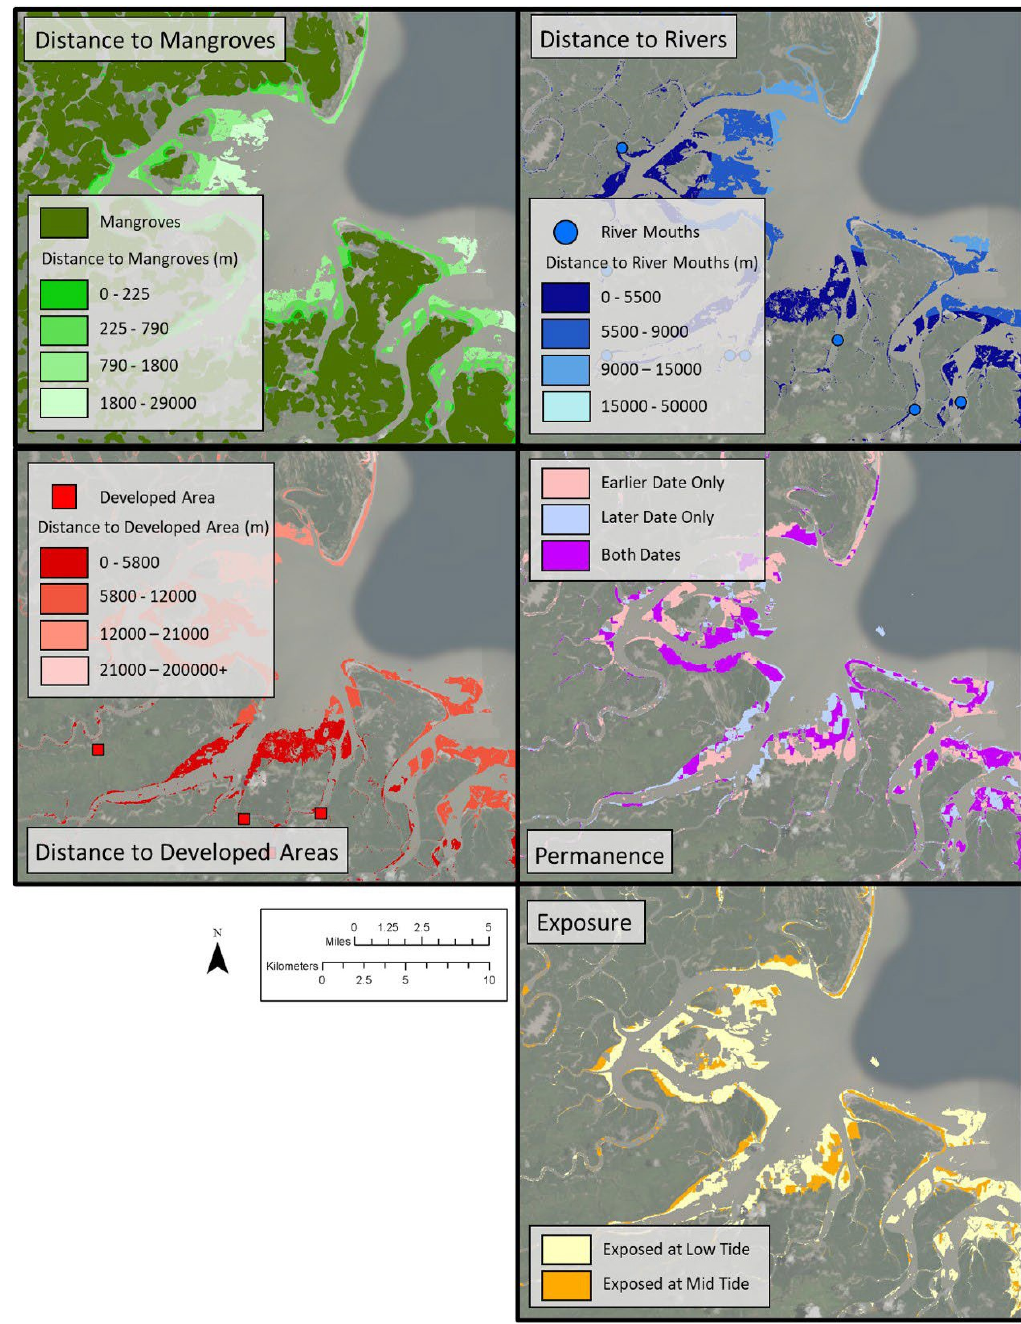
Figure 3. Sample area illustrating the five landscape metrics within the intertidal zone.